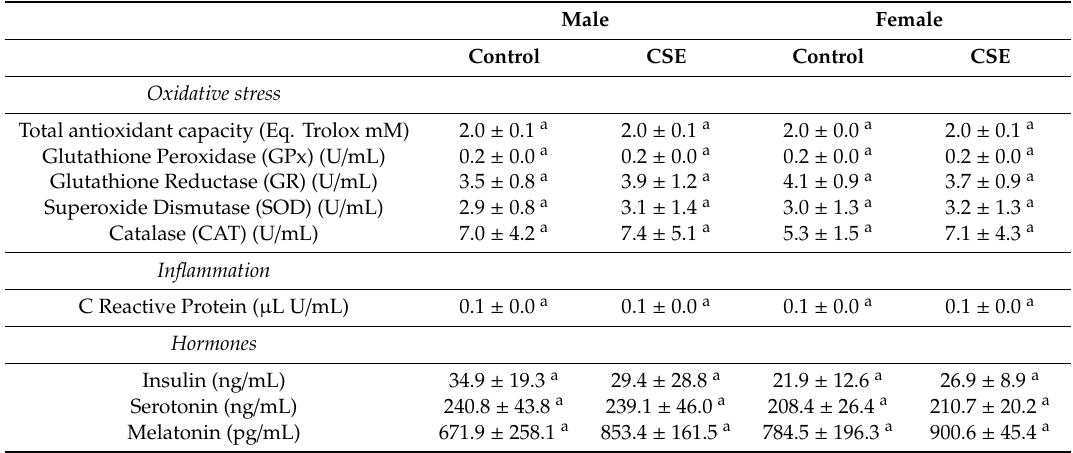
Table 5. Analyses of serum from control rats ( n = 15) and rats treated with CSE (1 g / kg) ( n = 15). Male